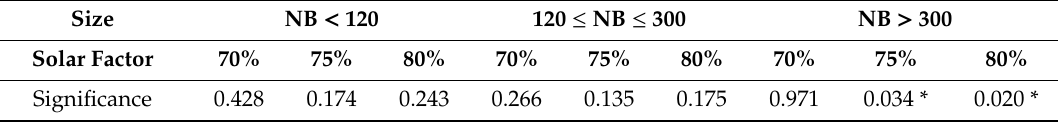
Table 8. Shapiro–Wilk’s test results for data categorized by NB-based size.